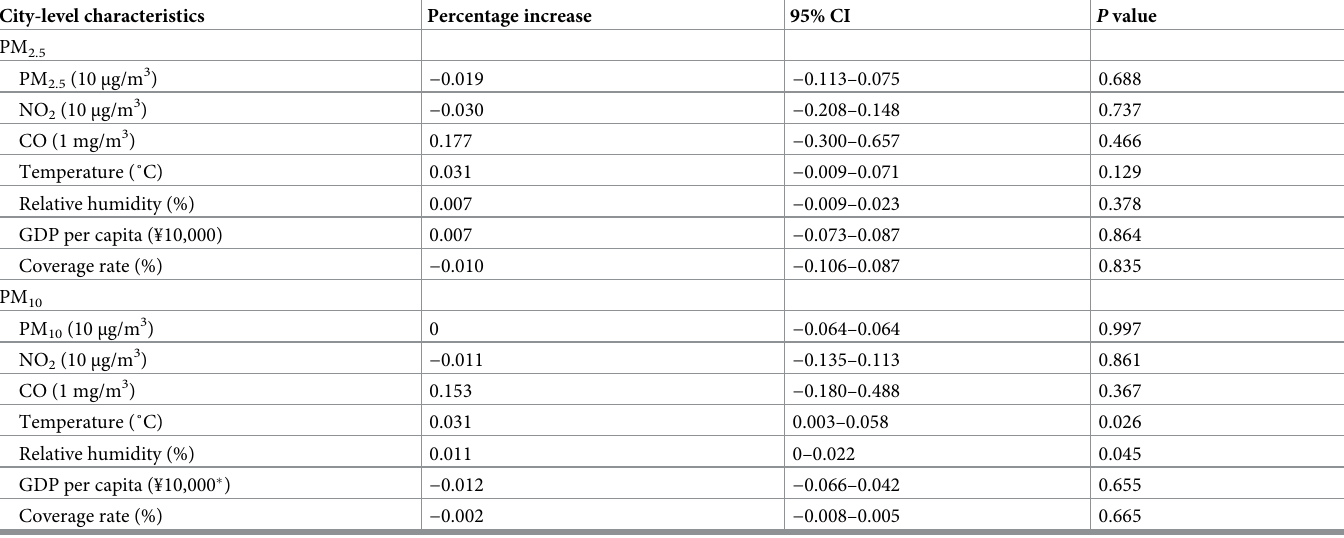
Table 5. Meta-regression results of the modification effects of city-level characteristics on the associations between PM 2.5 and PM 10 and hospital admissions for pneumonia in 184 Chinese cities,